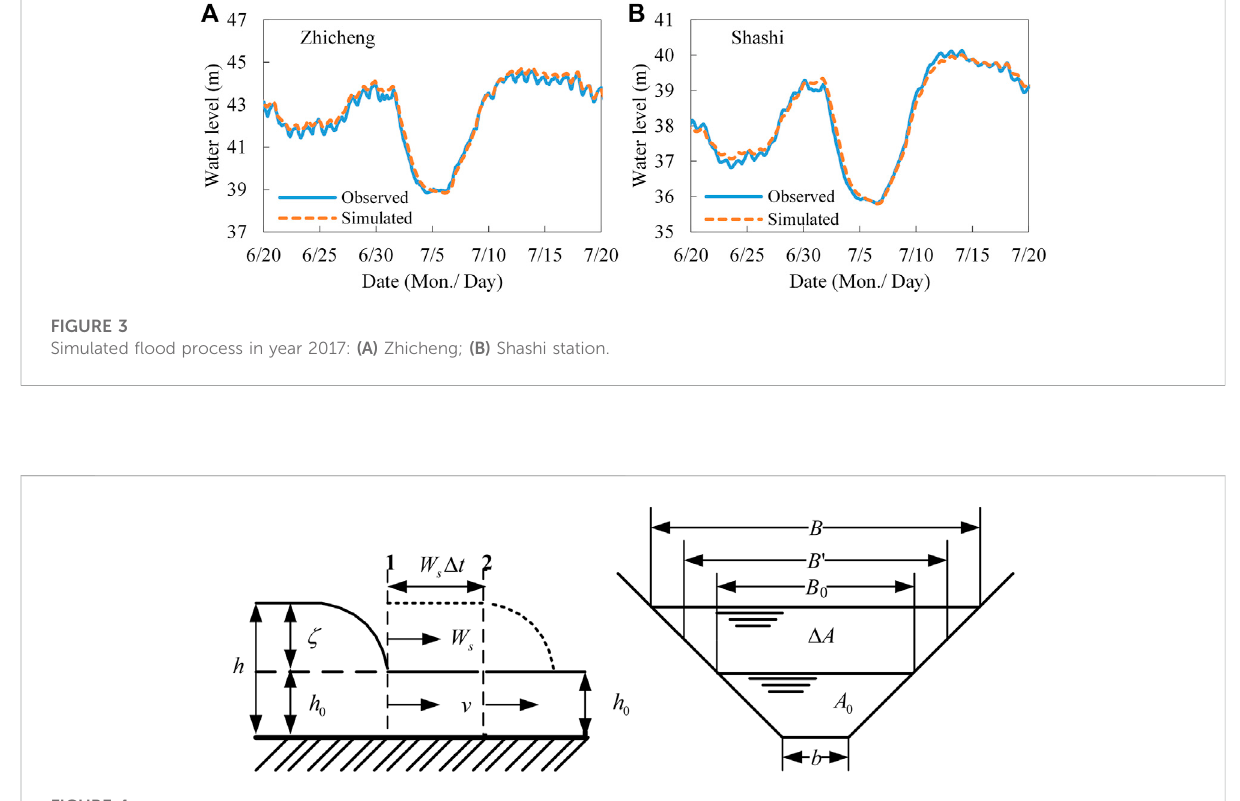
FIGURE 4 Delineation of surge propagation. ( A 0 represents the cross-sectional area of the early steady fl ow. ζ is the height of the surge. h 0 and B 0 are the waterdepthandwatersurfacewidthoftheearlysteady fl ow. A , B ,and v refertothecross-sectionalarea,crosswidthand fl owvelocityatthemoment of peak fl